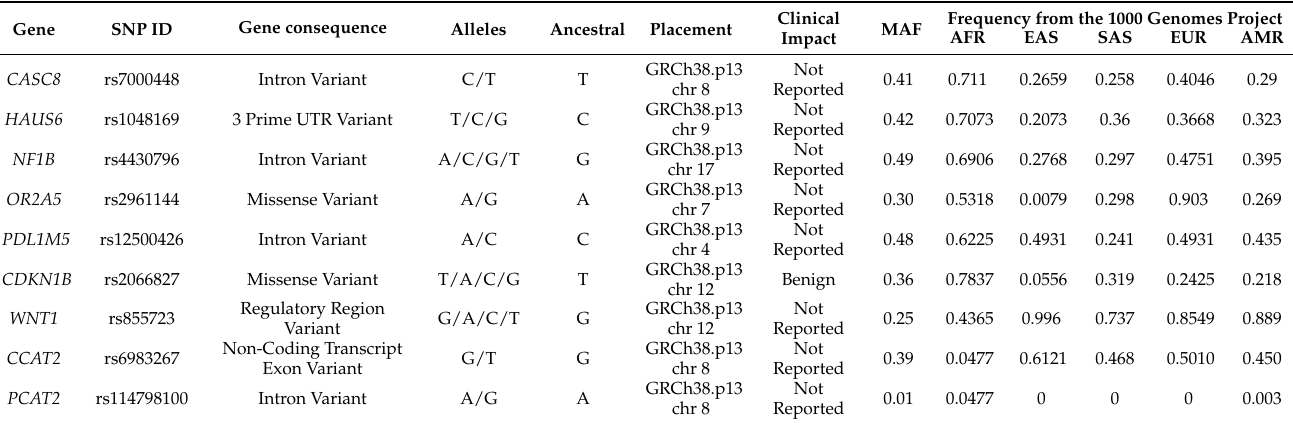
Table 2. SNPs significantly correlated with PCa incidence in different